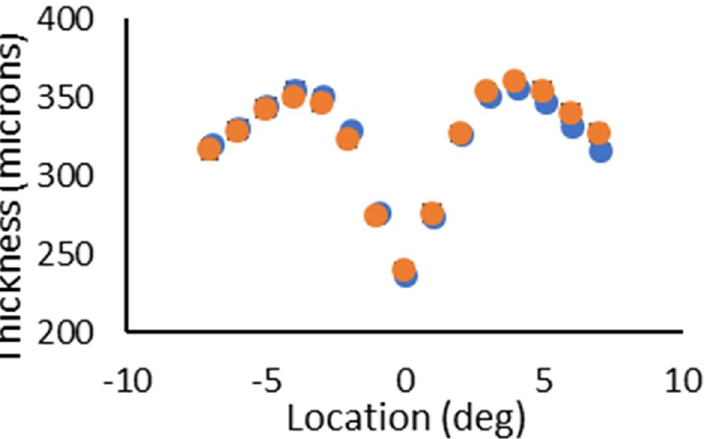
Fig 4. Thickness measurements for the domain of the full retina. Location 0 is the fovea, negative locations are in degree steps temporal to the fovea, and positive locations are in degree steps nasal to the fovea. There were no statistically significant differences in thickness between the diabetic and control subjects at any location, with diabetics in blue and controls in orange. That is, the trends seen in the figure are not significant, for diabetic subjects on average being thicker at all locations temporal to the fovea, and the control subjects being thicker on average at the fovea and for all locations nasal to the fovea.